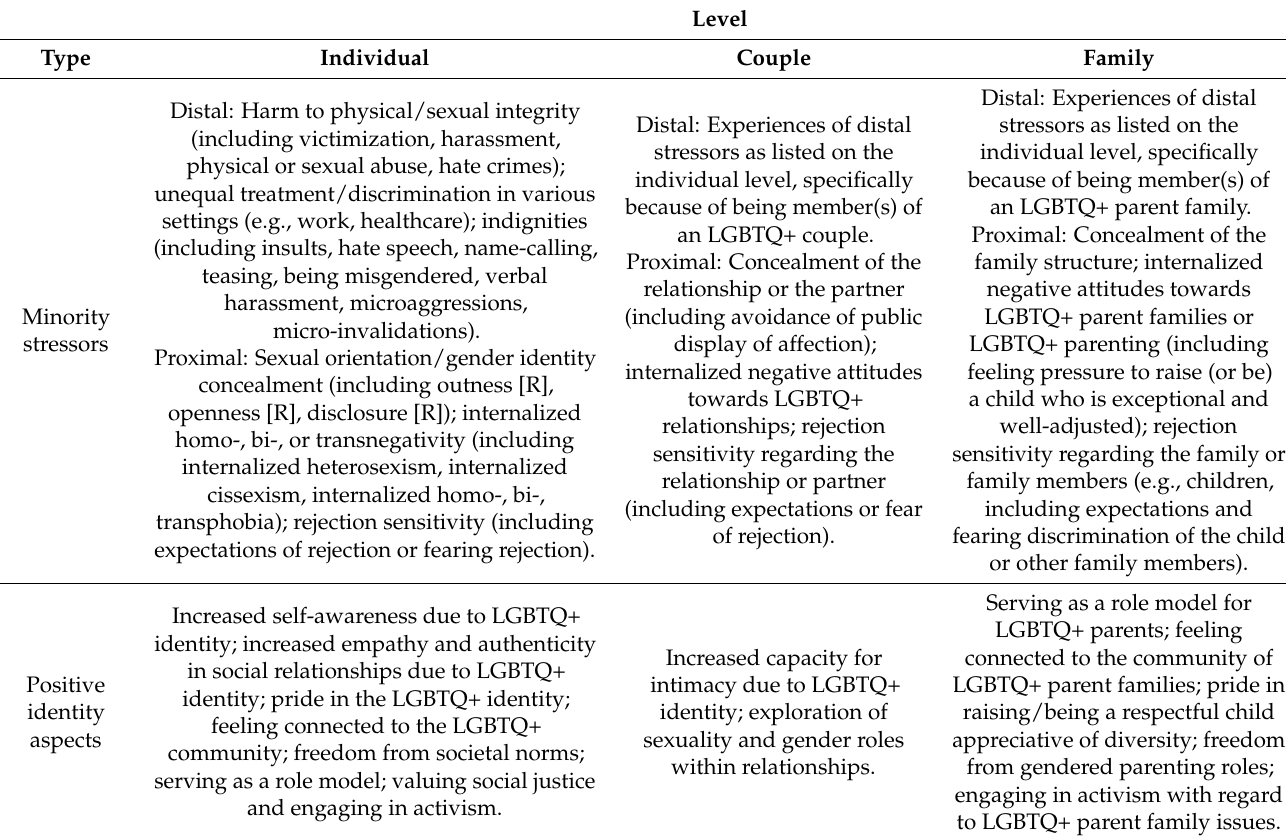
Table 1. Non-exhaustive summary of eligible minority stressors and positive identity aspects on the individual, couple, and family